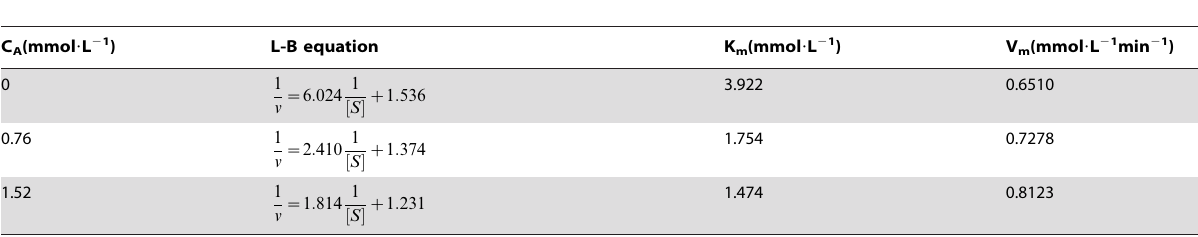
Table 1. Kinetic parametes of diphenolase by a